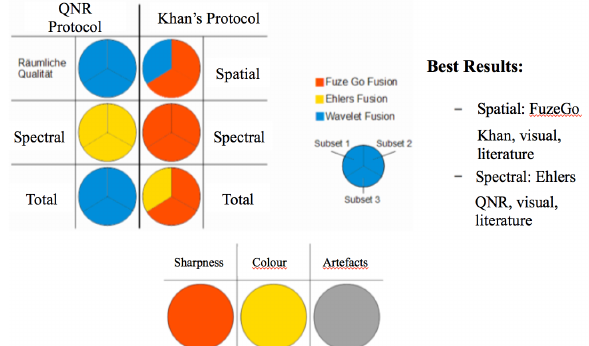
Figure 2. Quantitative quality assessment result for urban land cover - adapted from (Moellmann